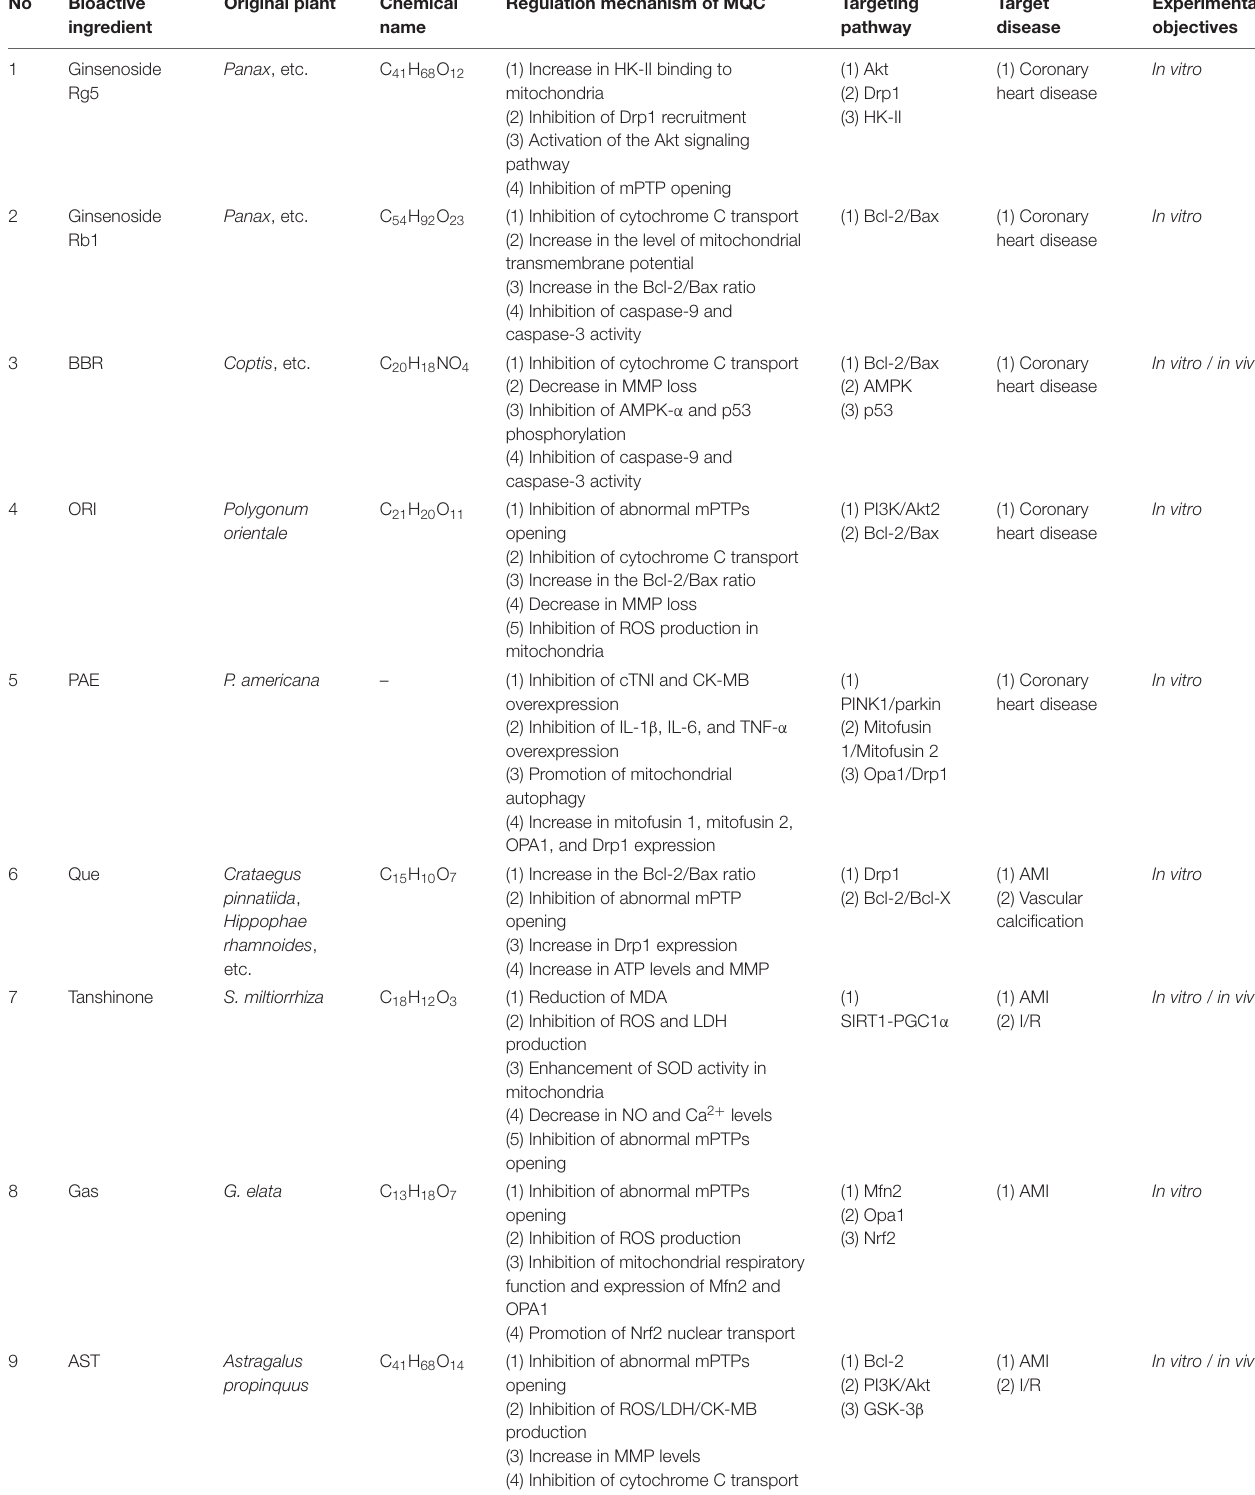
TABLE 2 | Regulatory mechanism of MQC by different natural drugs in